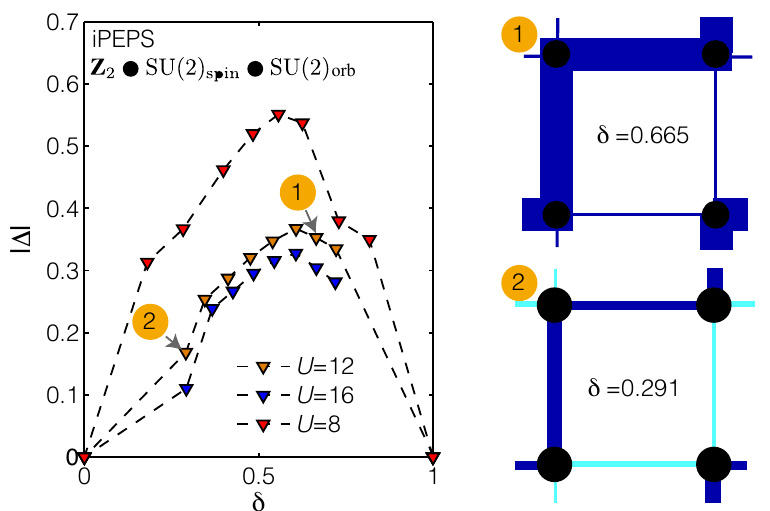
Figure 10: Generalized singlet-pairing amplitude | ∆ | per site, extracted from iPEPS wavefunctions with D ∗ = 5 as a function of the hole doping δ . | ∆ | ≡ 〈| ∆ ij |〉 is obtained by averaging over the absolute value of ∆ ij for each bond in the unit cell. Labels 1 and 2 point to individual iPEPS wavefunctions characterized on the right, where the filling per site and the singlet-pairing amplitude are proportional to the diameter of the black dots and the width of the bonds, respectively [ blue (cyan) bond correspond to positive (negative) ∆ ij ]